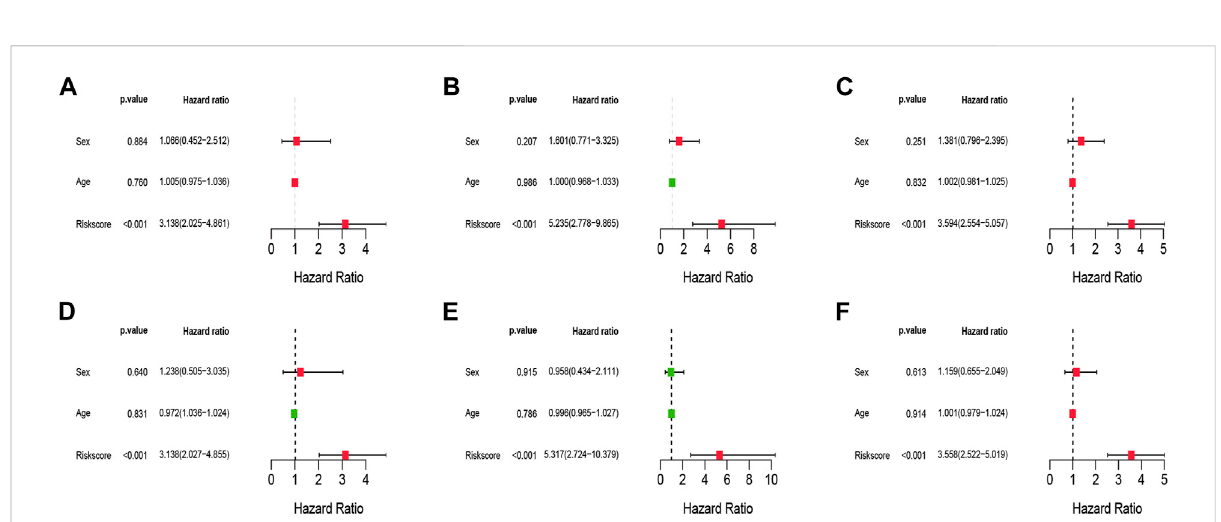
FIGURE 6 Univariate and Multivariate Cox analysis of the risk signature. (A – C) The Univariate Cox analysis of the risk signature in training cohort, test cohort, and total cohort. (D – F) The Multivariate Cox analysis of the risk signature in training cohort, test cohort, and total